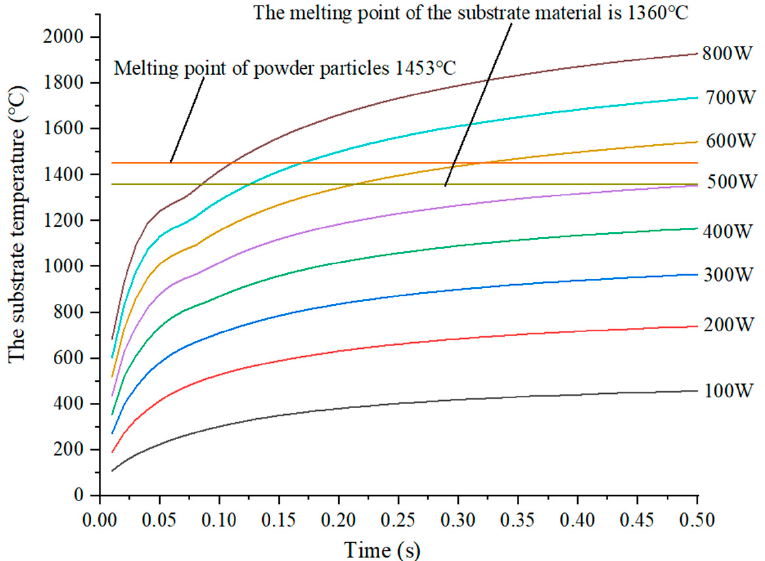
Figure 5. The relationship curve between the substrate temperature and the time.